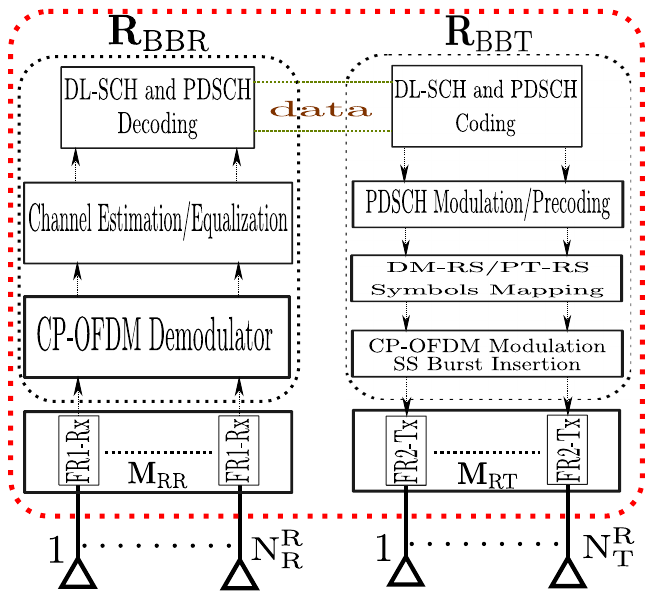
Figure 3. mmWave MIMO NR Decode-and-Forward (D&F) Relay Node (RN)